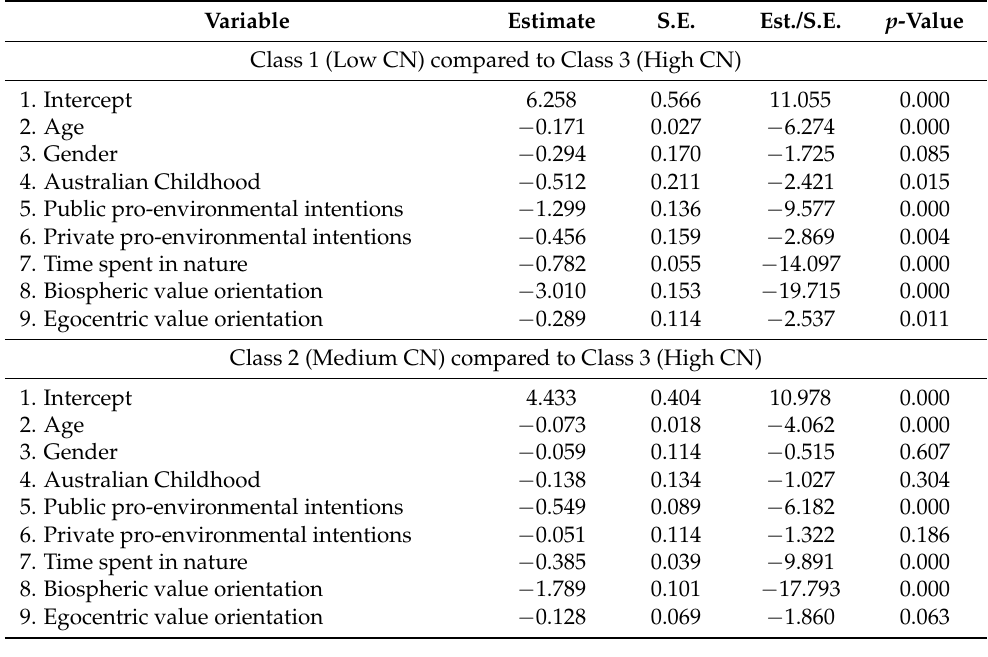
Table 5. Comparison of membership between classes with Biocentric Value Orientation included.